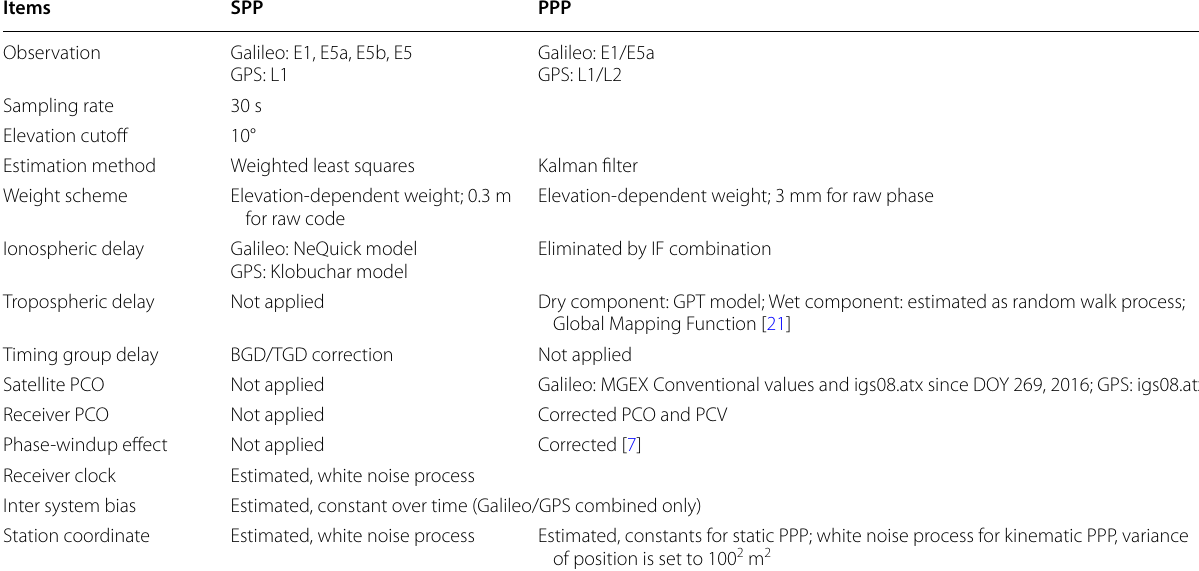
Table 1 Processing strategies for SPP and